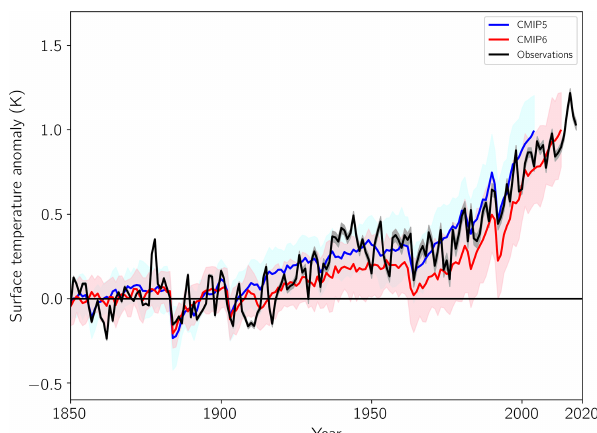
Figure 12. Ensemble mean historical surface warming in CMIP5 and CMIP6 compared with observations. Shading on the models is the ensemble SD. The baseline is 1850–1900.